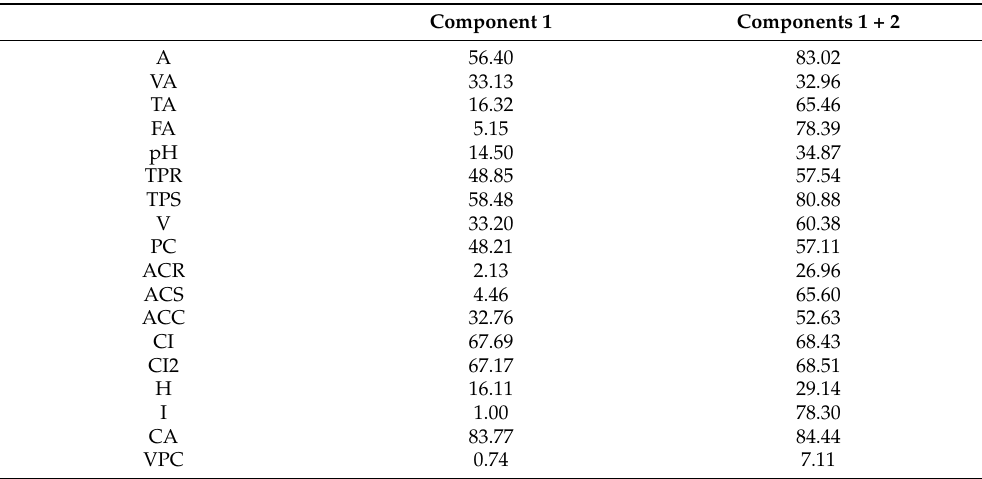
Figure 6. PLS-BLR Triplot for the wine data showing only the variables with a predictiveness higher than 0.6. Table 4. Cumulative qualities of the columns (percent of the variability of the variable accounted for the first dimension and the sum of the first